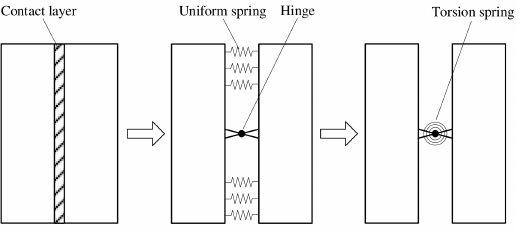
Figure 3. Equivalent diagram of contact characteristics between two disks.